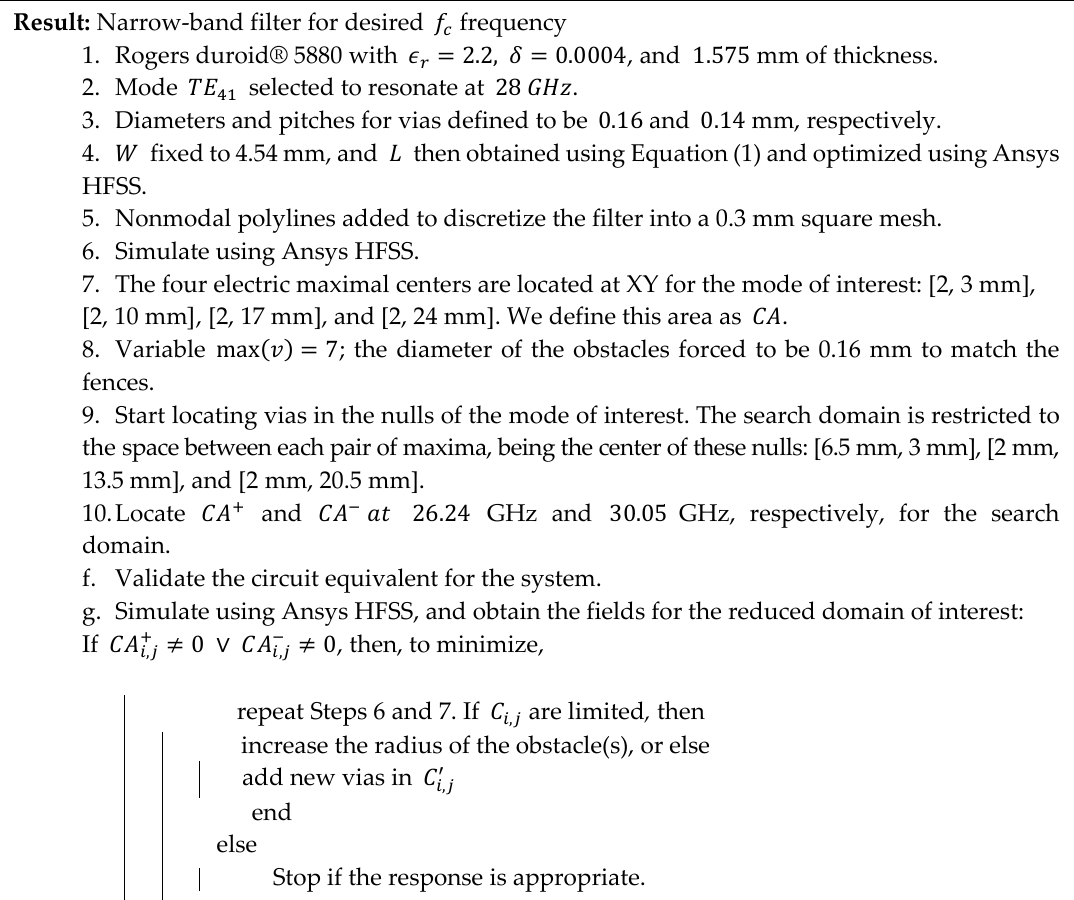
Algorithm 2: Application of Algorithm 1 on the design of 28 GHz narrow-band filter. Result: Narrow-band filter for desired 𝑓 (cid:3030)